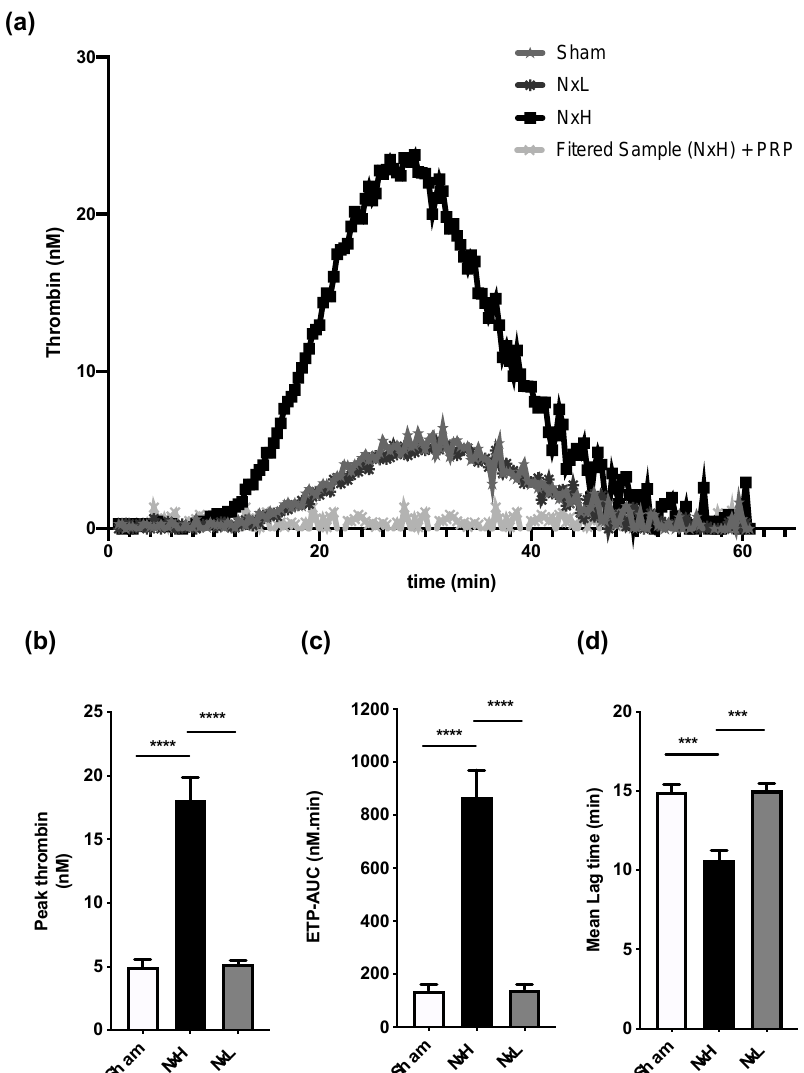
Figure 3. Calibrated automated thrombography showing the prothrombotic e ff ects of MVs in rats’ plasma. ( a ) Representative thrombin generation curves form each subject group ( b ) Peak